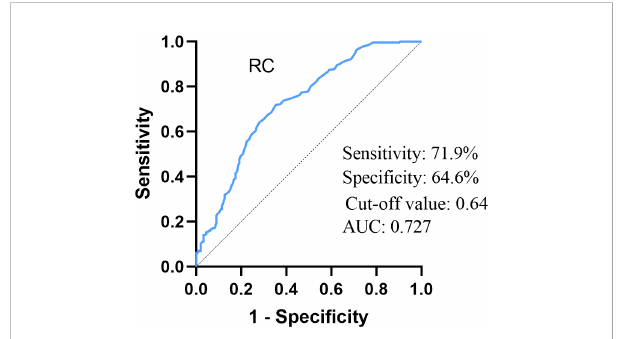
FIGURE 2 ROC curve analysis of the ability of RC to predict T2DM – PAD. RC, remnant cholesterol. AUC = 0.727, 95% CI:0.683 – 0.770, P = 0.000, cut-off: 0.64, sensitivity 71.9%, speci fi city 64.6%.